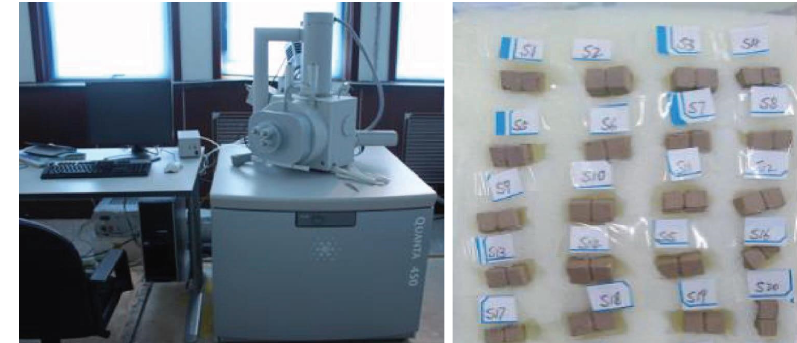
Figure 2: Scanning electron microscope and samples.